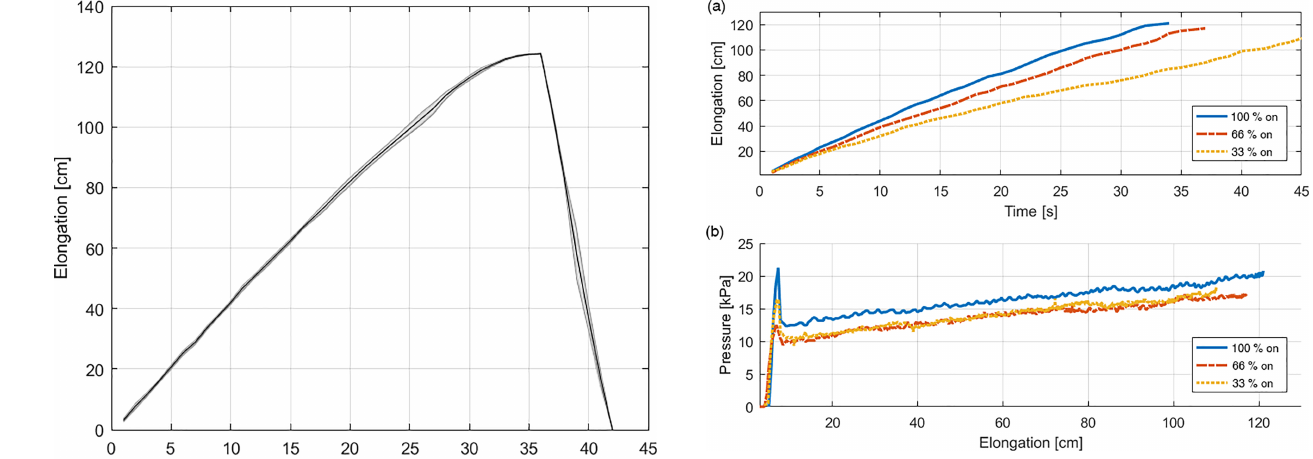
Figure 8. Elongation (a) and the pressure vs. elongation (b) of a single balloon inflated with three different duty cycles of the solenoid